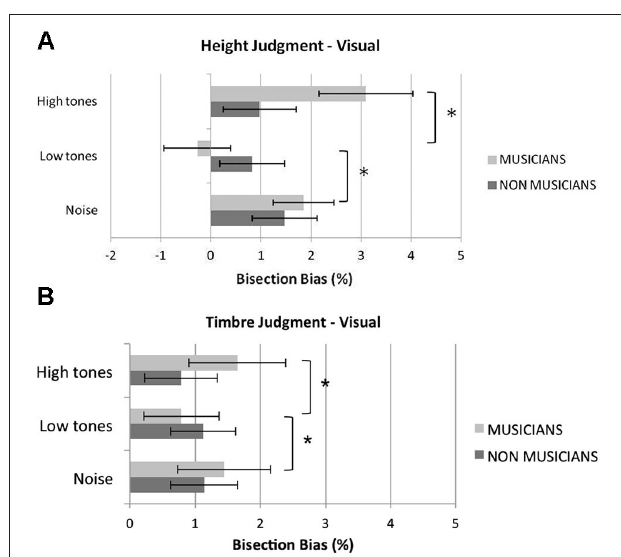
FIGURE 2 | Mean percentage visual bisection bias in the height (A) and in the timbre (B) judgment tasks in visually bisecting rods in the control (white noise), low tones and high tones conditions. Overall, listening to low tones shifted musicians’ bisection significantly to the left compared to listening to white noise or high tones; pitch of the tones did not affect non musicians’ performance. Error bars represent ± 1 SEM. Asterisks indicate significant differences between task